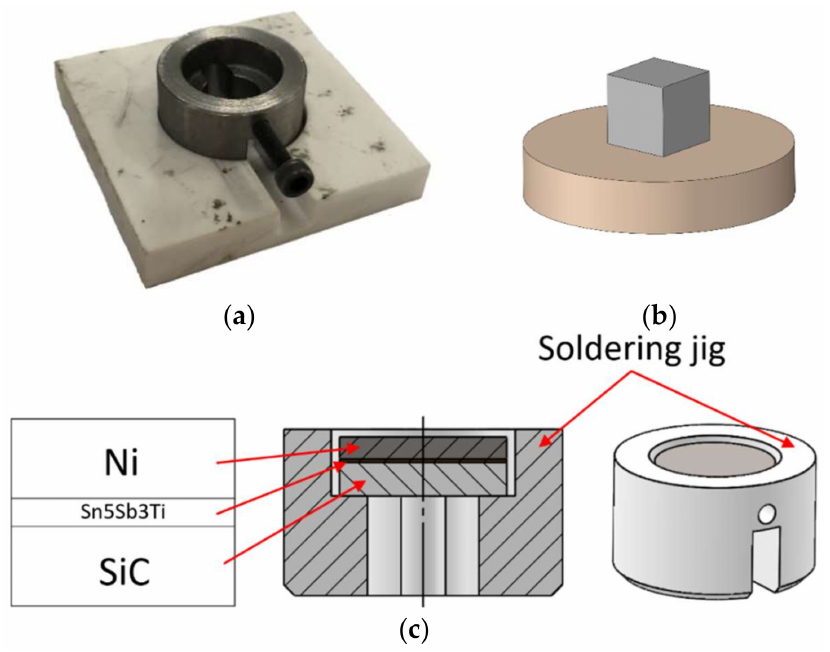
Figure 2. Graphical representation of a jig for experimental soldering. ( a ) real representation; ( b ) layout of solder for shear strength measurement; ( c ) schematic, in section representation of layout of soldered assembly in the jig.